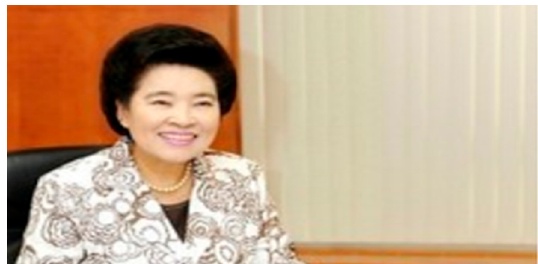
Figure 3. Zahng Gil-Jah, God the Mother of WMSCOG, public domain.